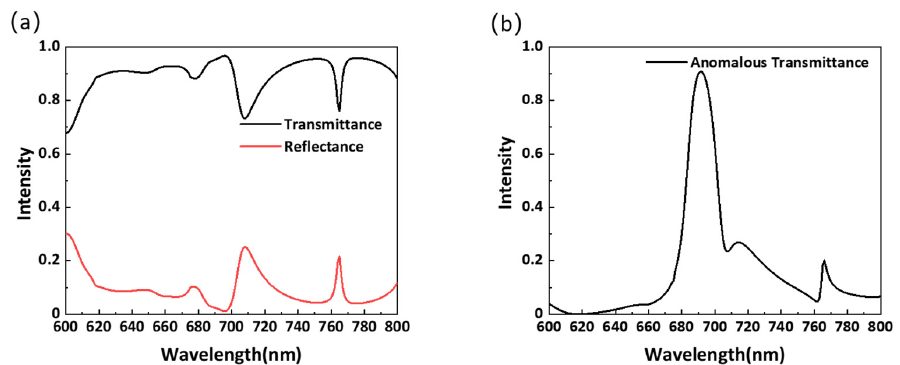
Figure 11. ( a ) Simulated intensities of the transmitted and reflected light. ( b ) Simulated intensity of the anomalous transmittance.